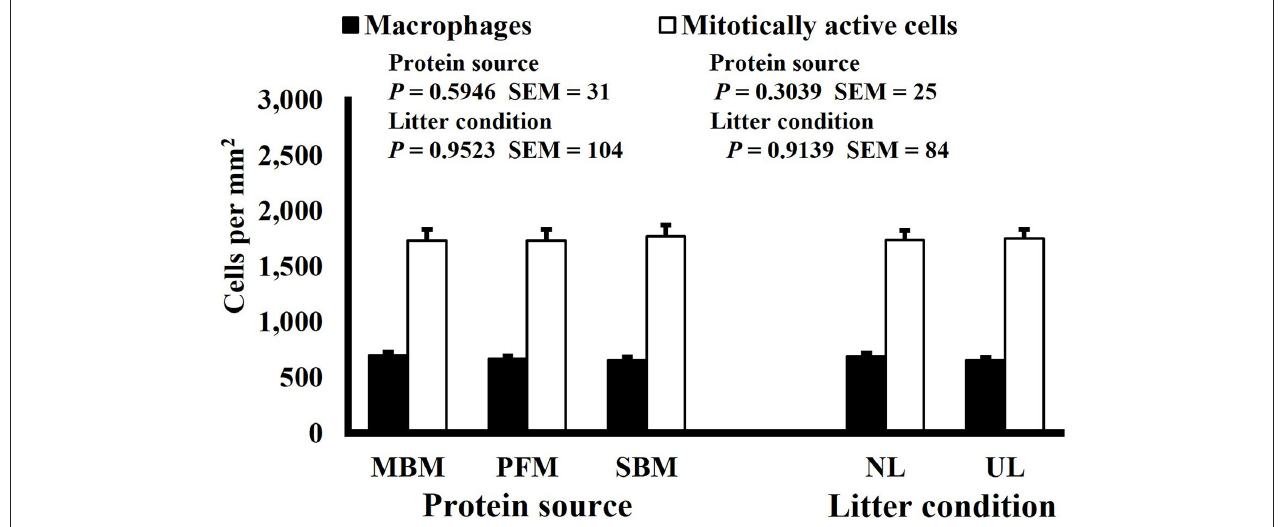
FIGURE 6 | Effect of dietary protein source and litter condition on macrophage (KUL01 + ) and mitotically active (BrdU + ) cell densities (cells per mm 2 ) in the ileum of 3-d-old broilers ( n = 36 per sampling d, 6 birds per treatment). MBM, meat and bone meal; PFM, 50% poultry by-product and 50% feather meal blend; SBM, soybean meal; NL, new litter; UL, used litter.